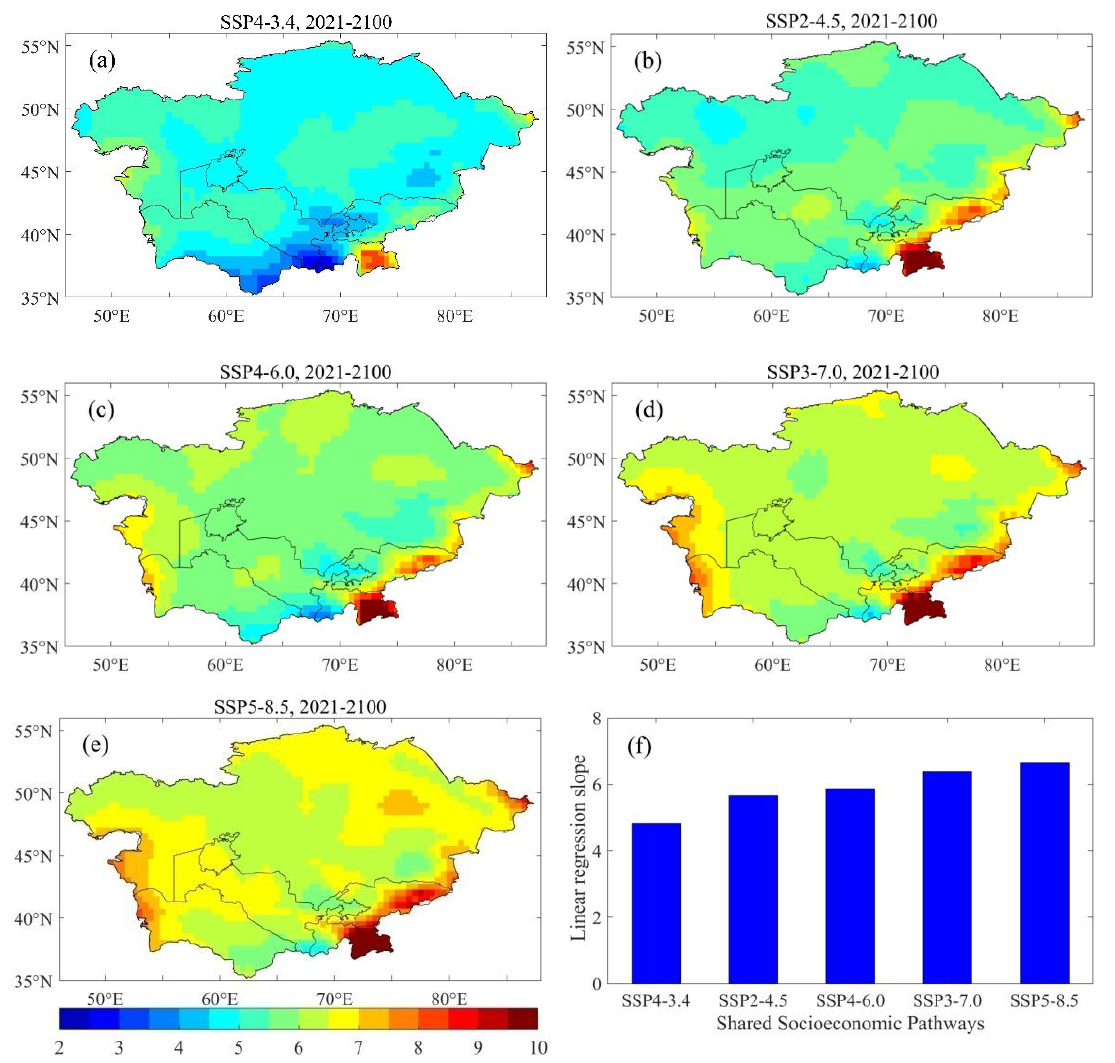
Figure 7. The linear regression slope between the mean increase in TCWV (%) and Ts (°C) from the MME for the period from 2021 to 2100, relative to the baseline period (1986–2005): ( a ) SSP4-3.4, ( b ) SSP2-4.5, ( c ) SSP4-6.0, ( d ) SSP3-7.0, ( e ) SSP5-8.5, and ( f ) average of linear regression slope under five scenarios.